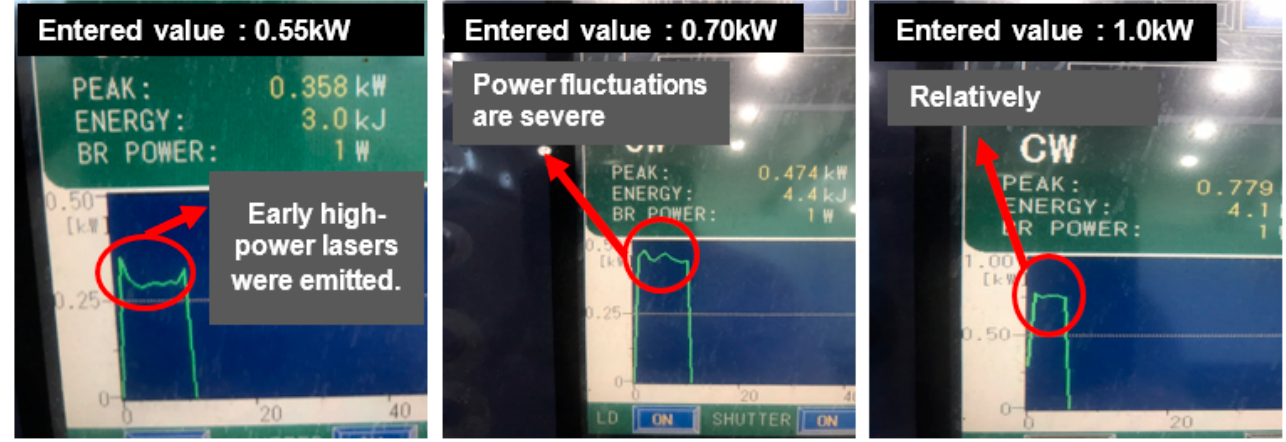
Figure 9. Laser power monitoring.